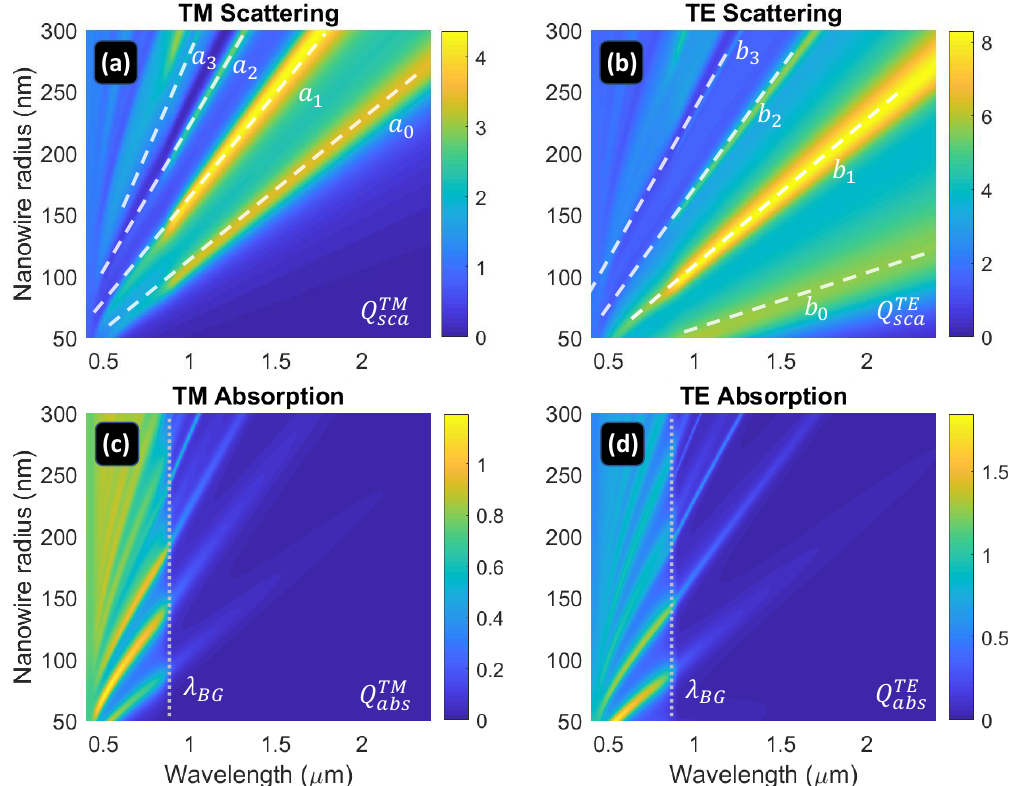
Figure 3. Scattering ( a , b ) and absorption ( c , d ) efficiency spectra for TE-polarized incident light ( a , c ) and TM-polarized incident light ( b , d ) for GaAs nanowires with variable radius, r NW . The white dashed lines in ( a , b ) follow the maxima of the scattering coefficients. The white dotted lines indicate the electronic-bandgap wavelength of GaAs (~870 nm).